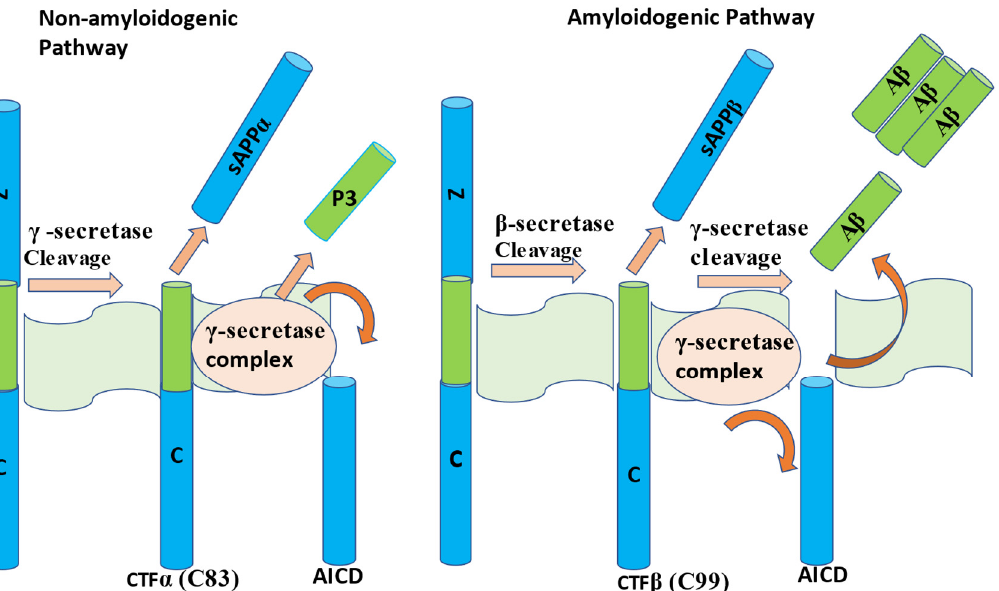
Figure 1. Illustration of APP amyloidogenic and non-amyloidogenic pathways [1,11]. The cleavage mechanism by γ -secretase is non-amyloidogenic, while β -secretase or α -secretase cleavage results in the amyloidogenic pathway. CTF α and CTF β are alpha and beta carboxy-terminal fragments, AICD represents the amyloid precursor protein intracellular domain.